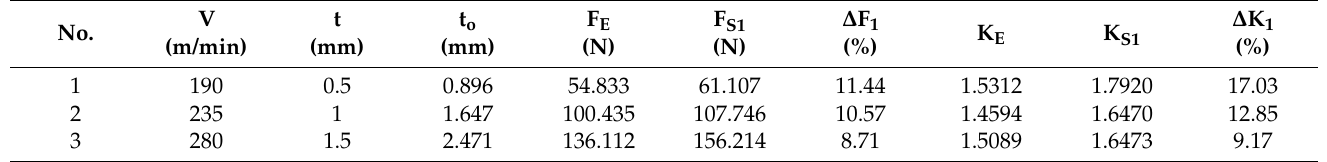
Table 5. The experimental and corresponding simulation